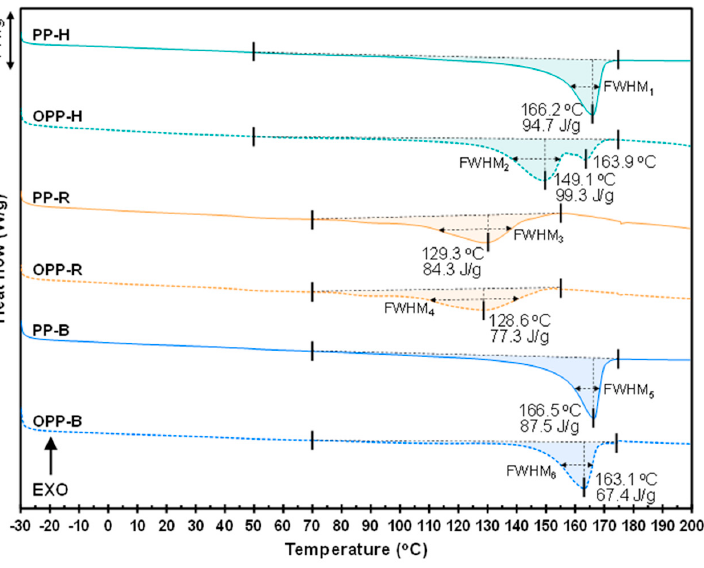
Figure 1. DSC thermograms of isotactic PP granules (homopolymer, random, and block copolymers) before and after oxidation at a heating rate of 5 °C under nitrogen.